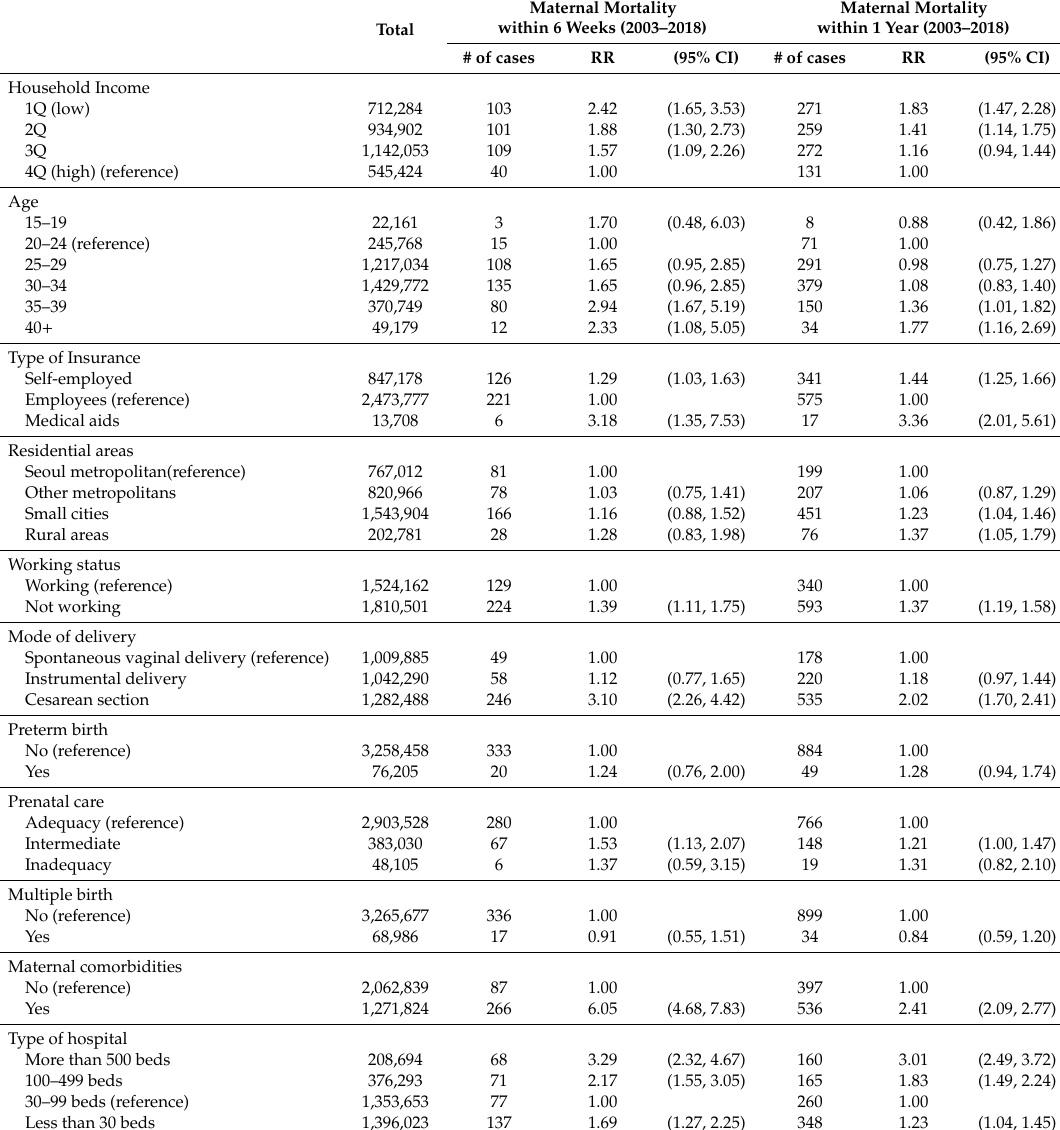
Table 2. The association between maternal mortality and maternal characteristics adjusted for all